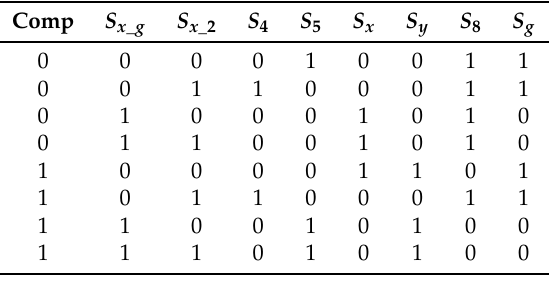
Table 7. Behavior of the injection decoder.